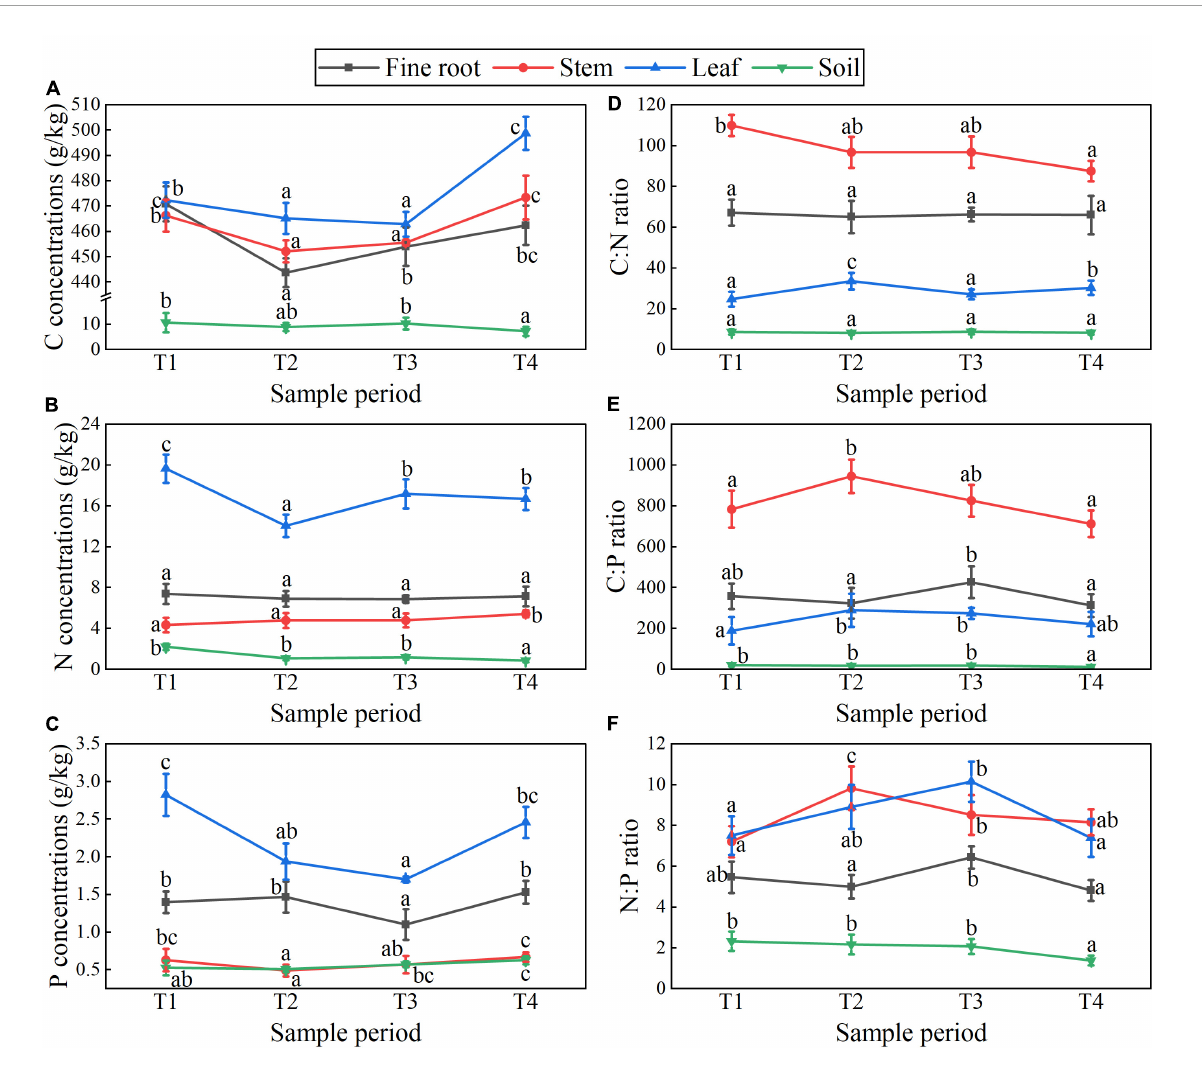
FIGURE6 T. distichum showed C, N, and P concentrations (A–C) and stoichiometry (D–F) dynamics in fine roots, stems, leaves, and soils at different sample periods. Data shows a statistically significant difference with different lowercase letters ( p < 0.05) across sample periods (mean with standard